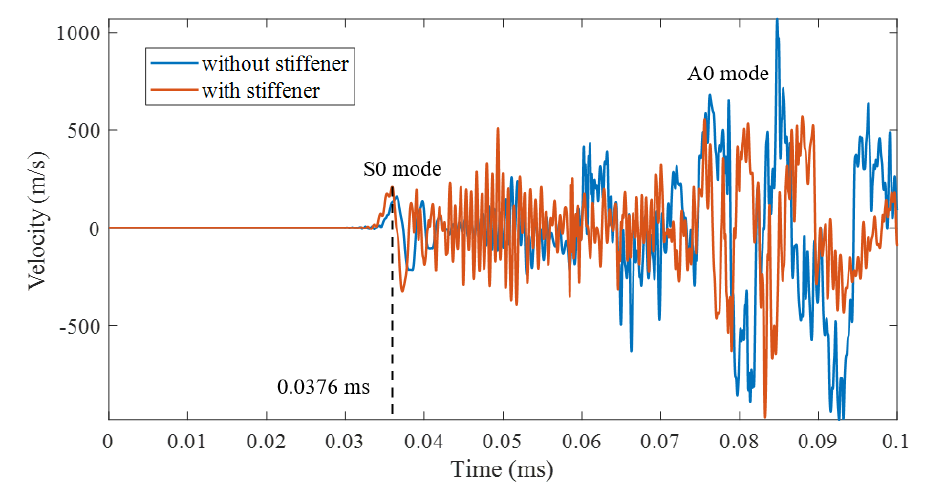
Figure 8. Simulated velocity comparison between flat plate and stiffened